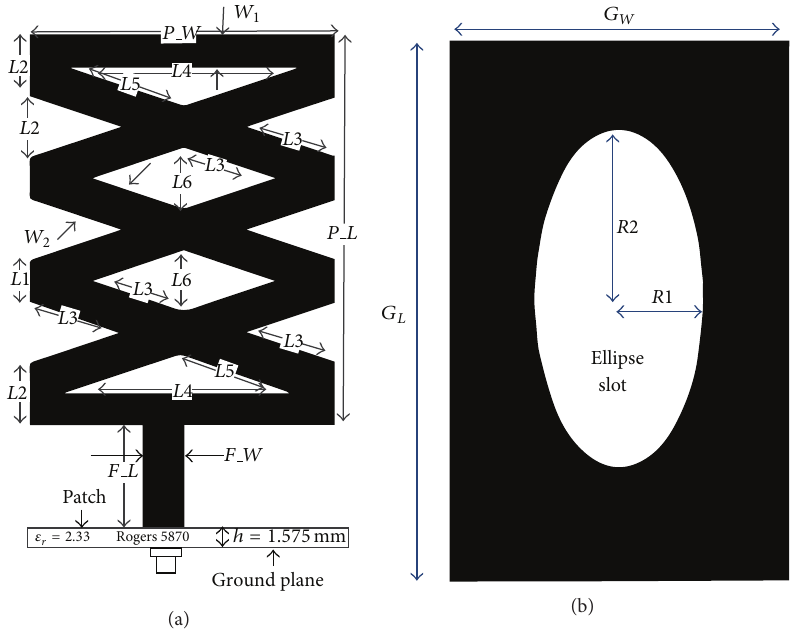
Figure 1: Proposed antenna geometry layout: (a) front and cross-sectional view and (b) bottom